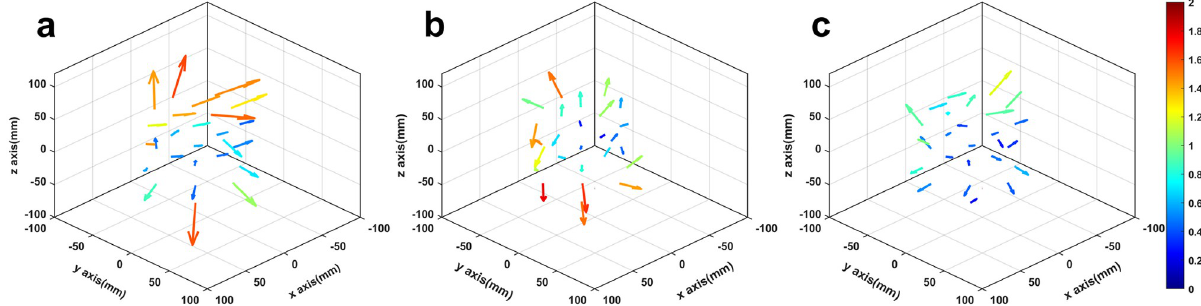
Fig 2. Vectors representing total spatial offset, d R . (a) MRI forward images, (b) MRI/CT dataset and (c) MRI-corrected images. Vectors’ origins correspond to the positions of the reference control points. Vectors’ lengths have been magnified to increase visibility but are proportional to the detected offsets which are quantified by the colorbar in mm. The MRI DICOM coordinate system is adopted.